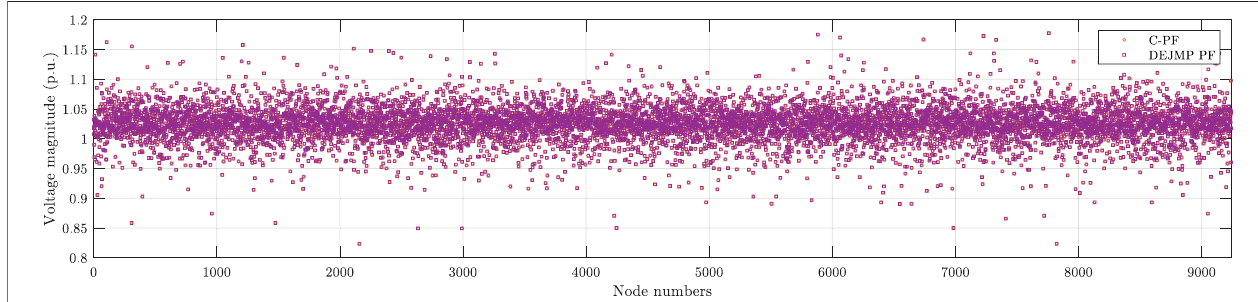
FIGURE 8 | the voltage magnitude obtained by DEJMP-based PF and C-PF on S-9241 bus